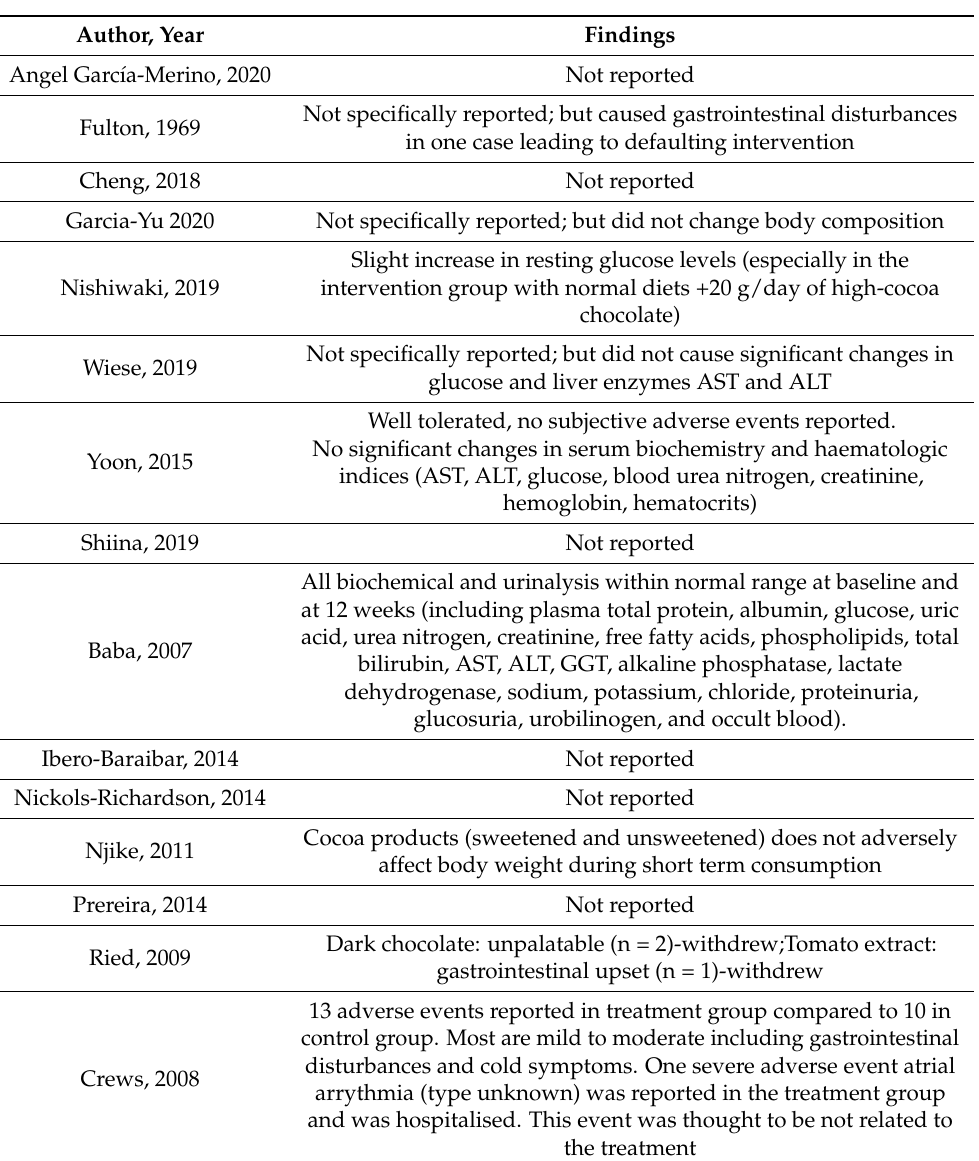
Table 2. Safety assessment of included